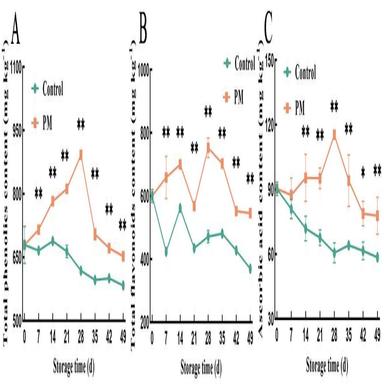
Effect of treatment of PM on the contents of total phenolics (A), total flavonoids (B), ascorbic acid (C), and total anthocyanins (D) of sweet cherries during storage at 0±2 ◦C from 0 d to 49 d. each value represents the mean for three replicates, and vertical bars indicates the standard deviations for each treatment (n = 3). The symbol \ represents significant statistical differences (p < 0.05).